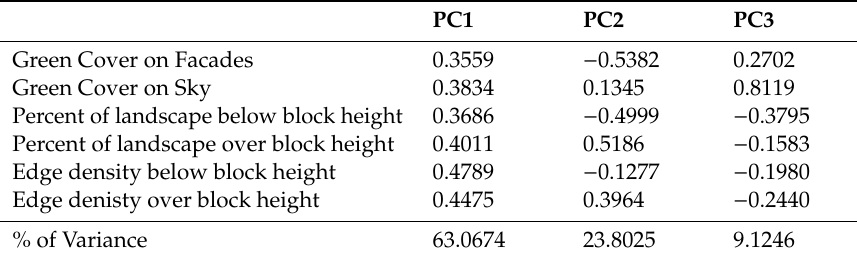
Table 3. Principal component analysis (PCA) dimensions.